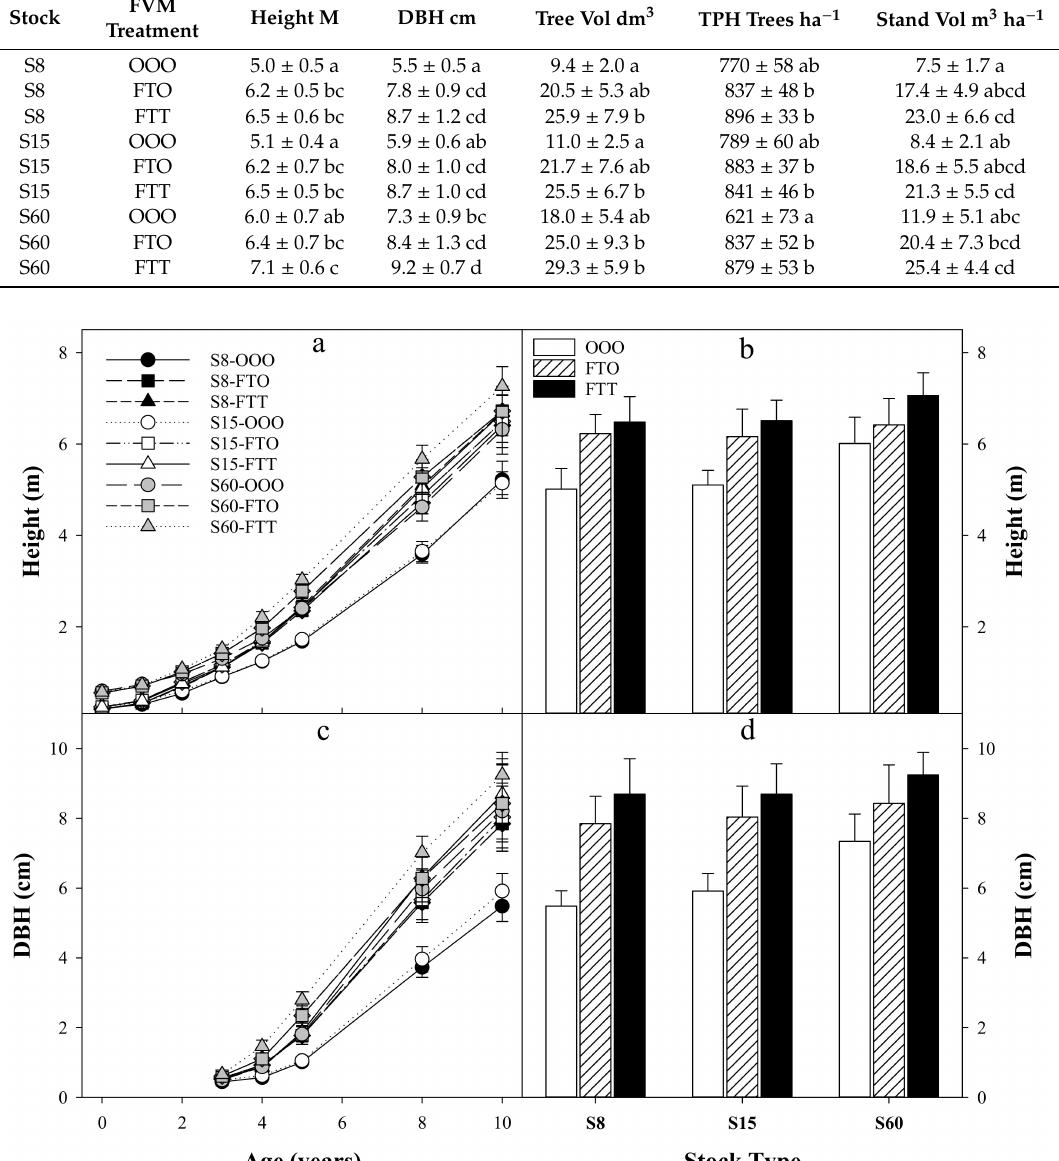
Table 3. Mean height (m), diameter at breast height (DBH, cm), mean tree volume (Tree Vol, m 3 ),